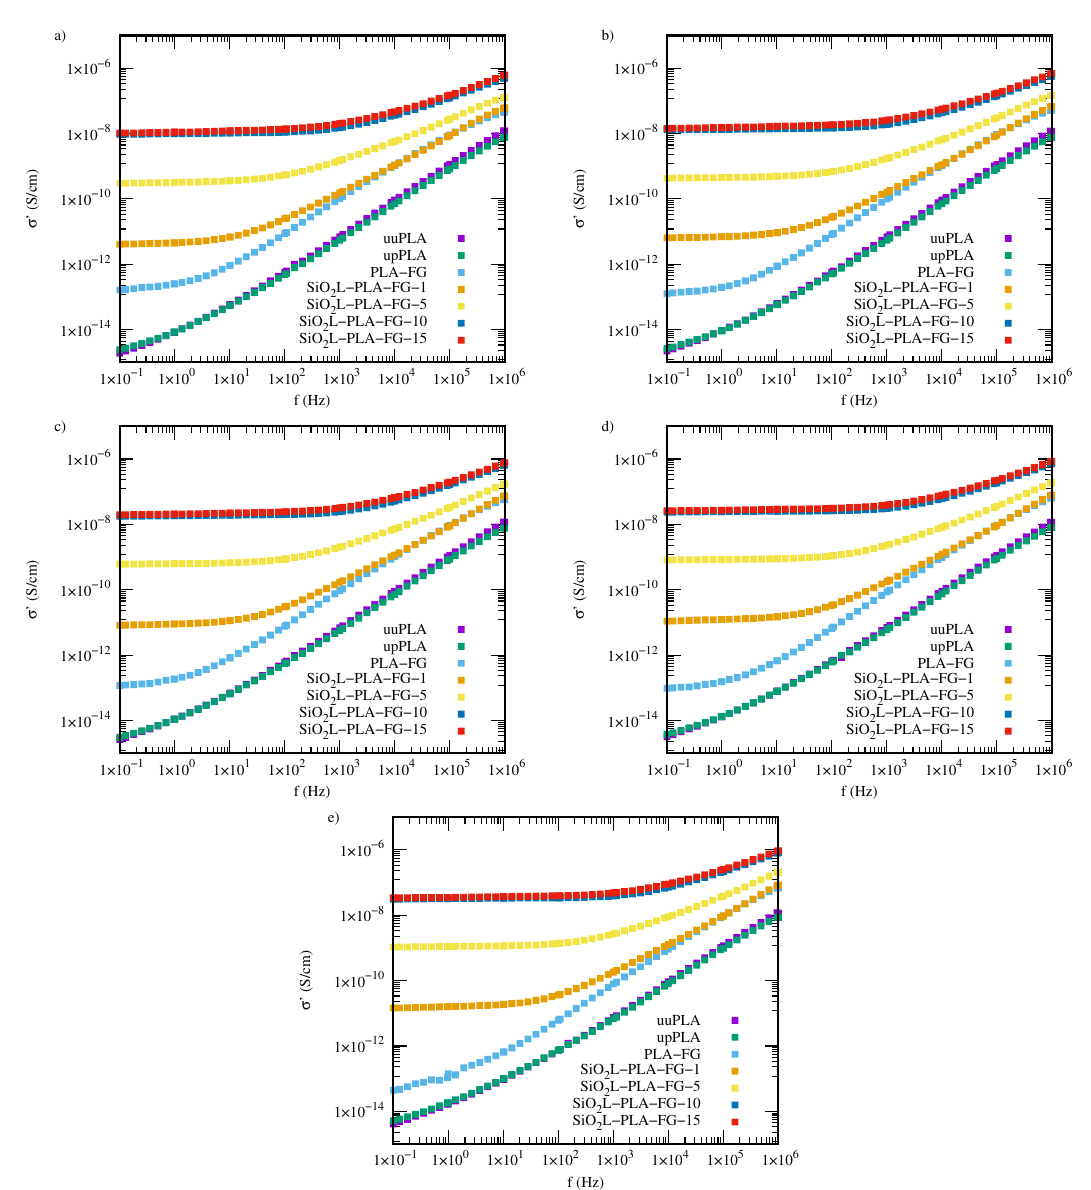
Figure A4. The real part of the complex permittivity of silicon-dioxide–lignin nanocomposites as a function of frequency for ( a ) 298.15 K, ( b ) 303.15 K, ( c ) 308.15 K, ( d ) 313.15 K, and ( e ) 318.15